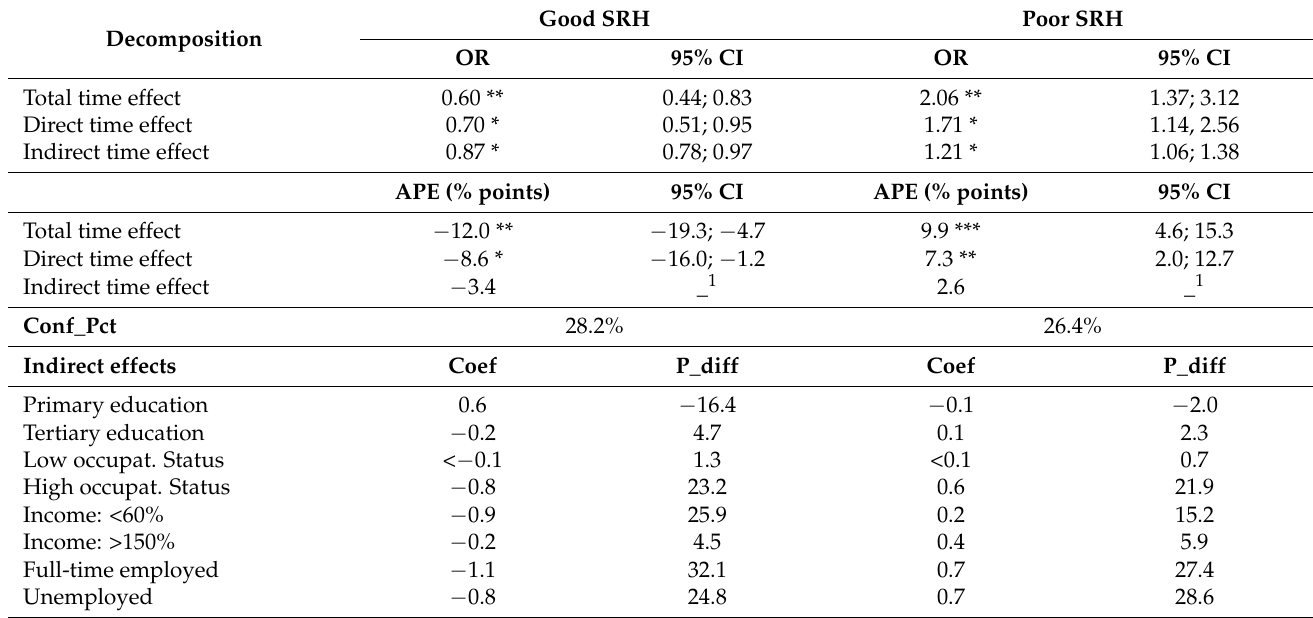
Table 7. Decomposition of the total time effect on self-rated health (SRH) among single mothers aged 30–49 years into direct and indirect effects via socioeconomic factors, Germany